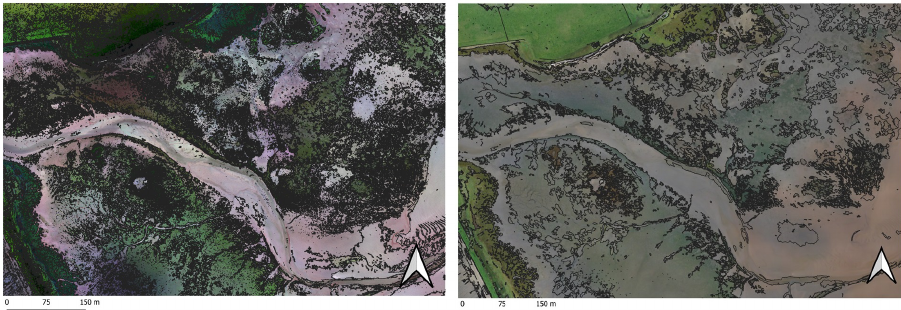
Figure 6. Segmented orthomosaics using the multiresolution segmentation algorithm. The scale, shape and compactness were respectively 200, 0.1 and